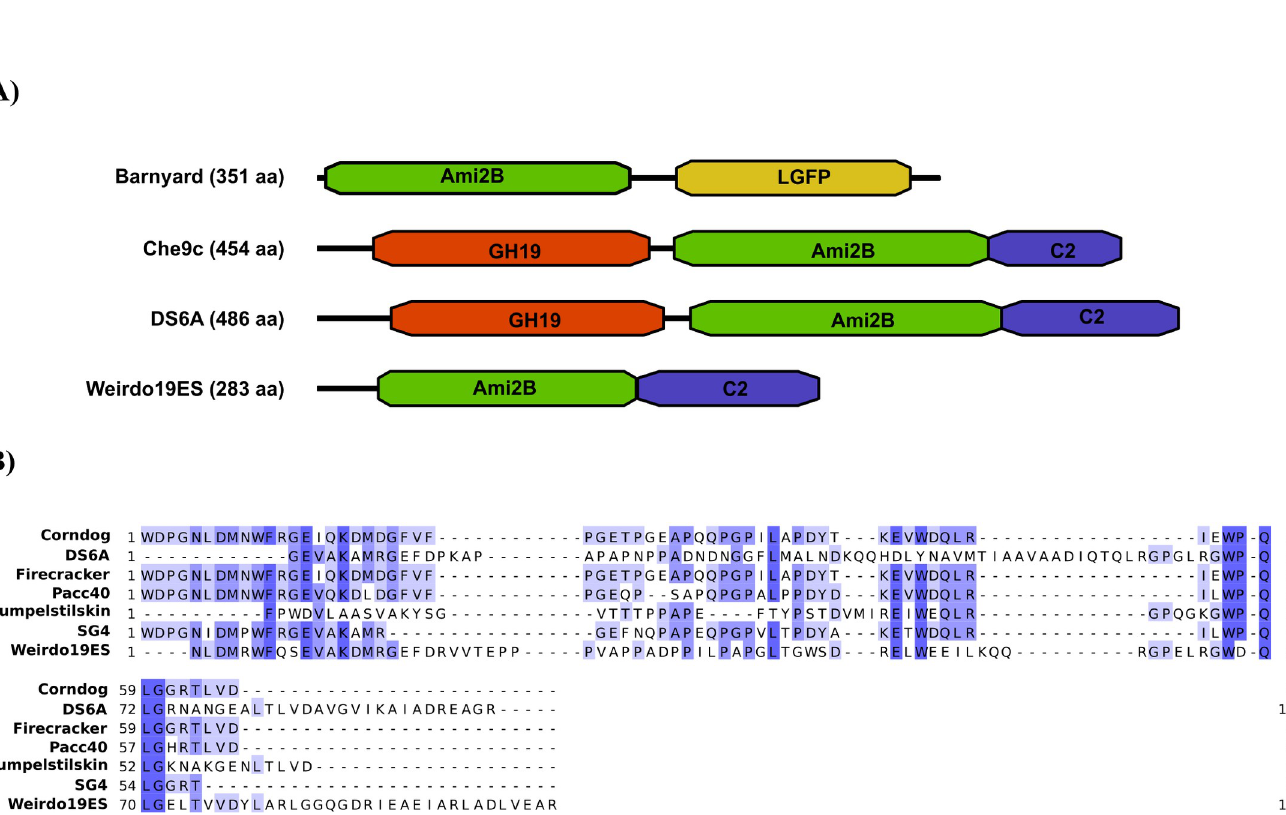
PLOS ONE | https://doi.org/10.1371/journal.pone.0231881 May 1, 2020 6 /